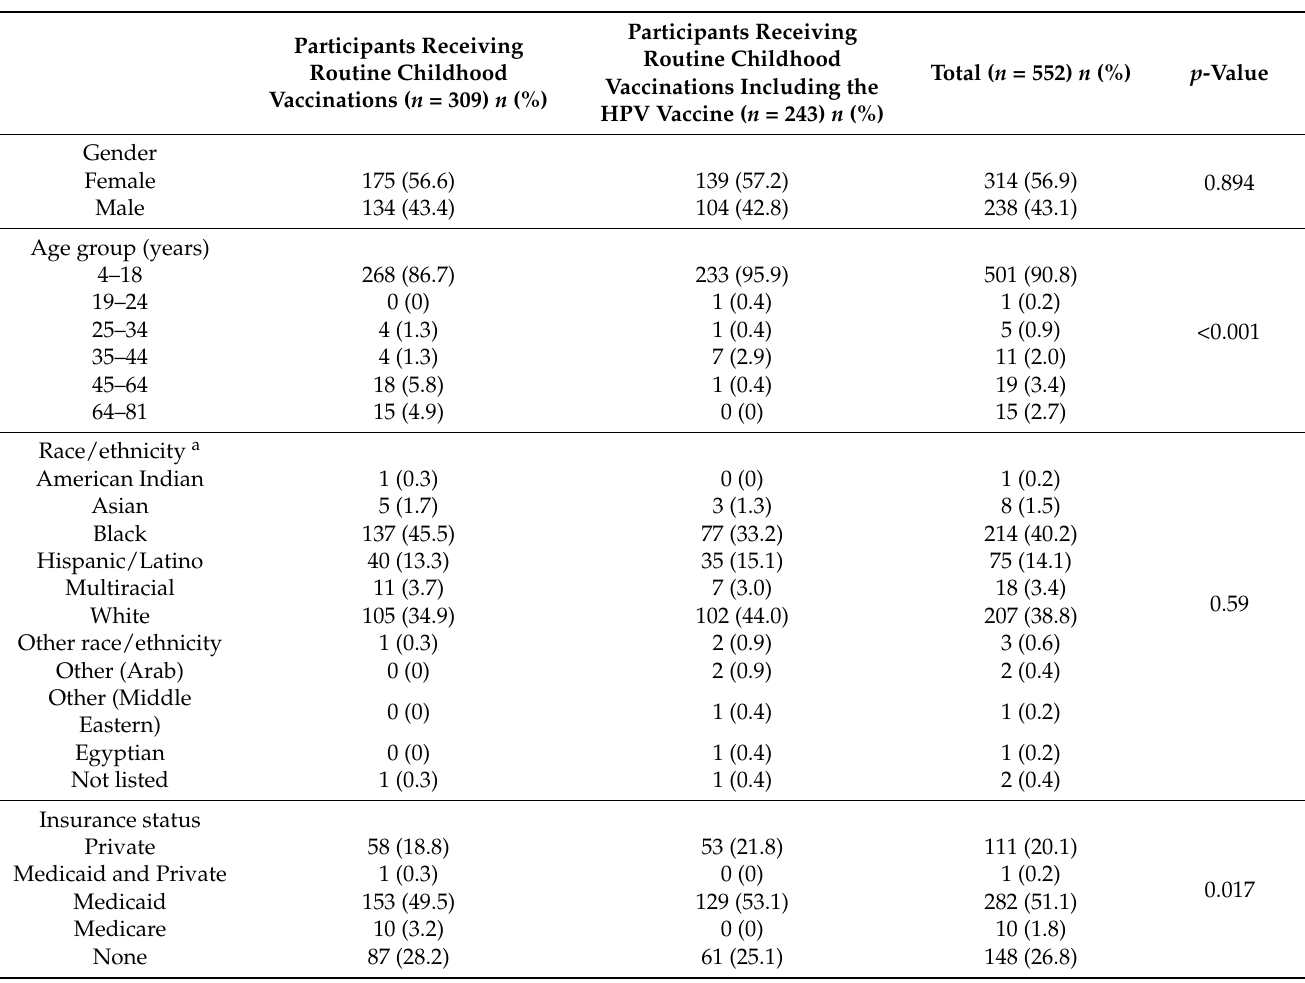
Table 2. Sociodemographic characteristics of the HPV Van Vaccination Program participants overall and by receipt of routine childhood vaccinations with or without the HPV vaccine a .